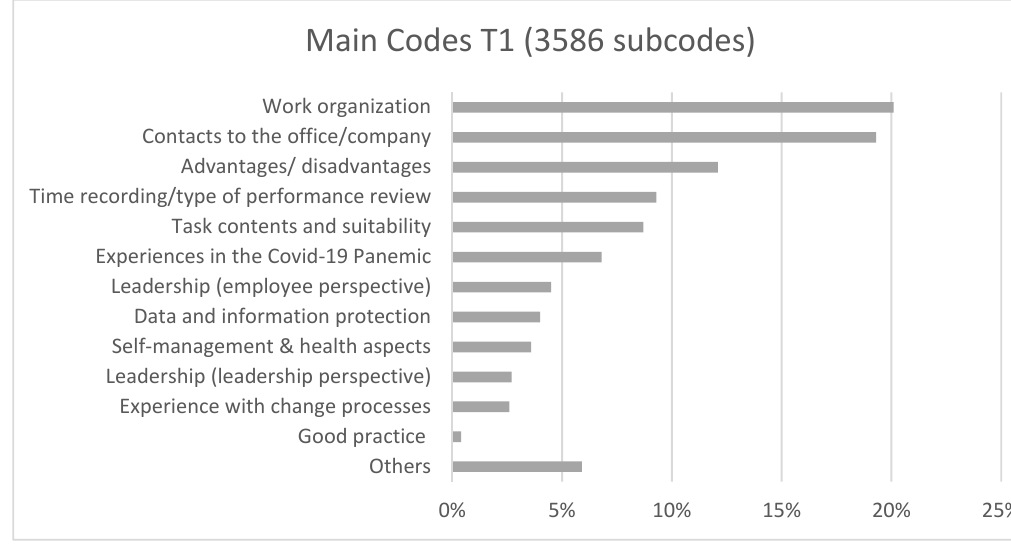
Figure 3. Categorical frequencies of T1.